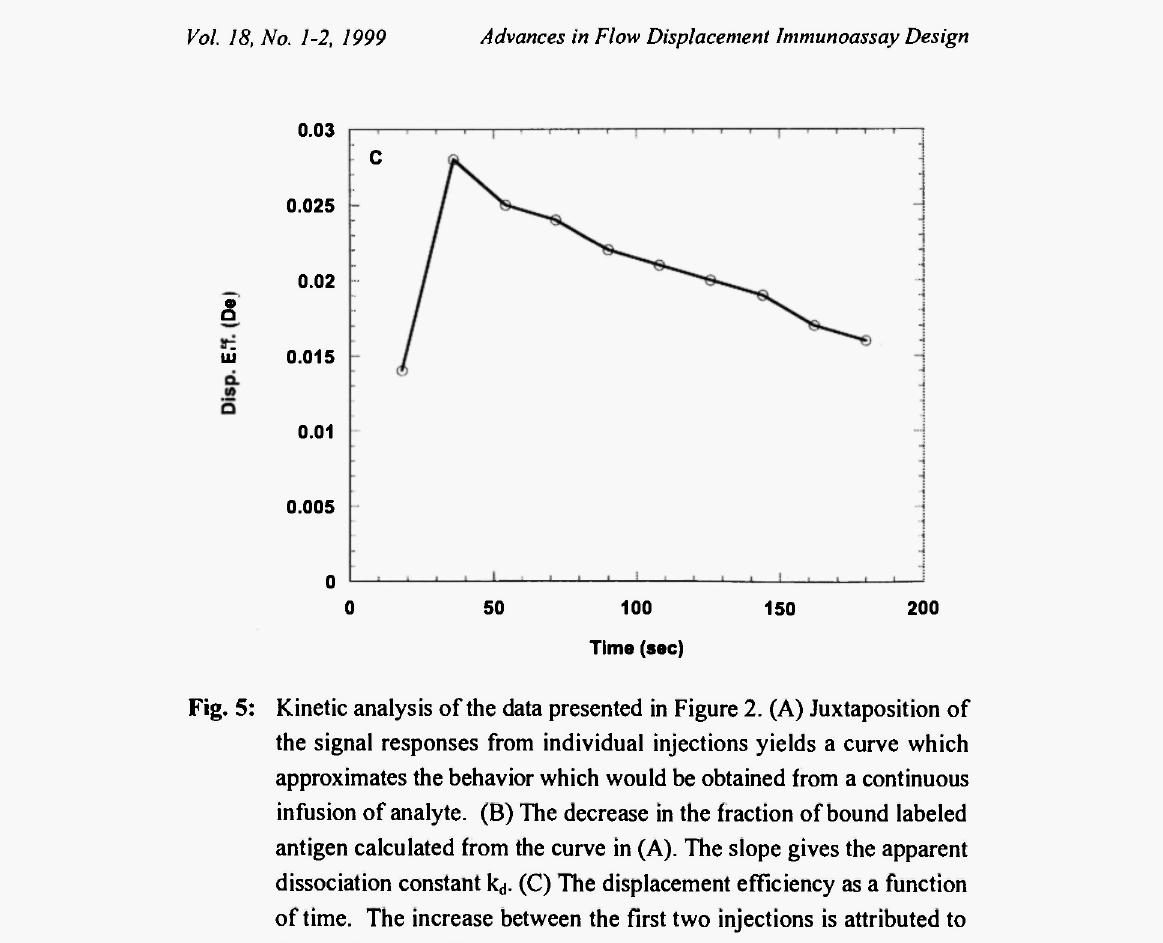
Fig. 5: Kinetic analysis of the data presented in Figure 2. (A) Juxtaposition of the signal responses from individual injections yields a curve which approximates the behavior which would be obtained from a continuous infusion of analyte. (B) The decrease in the fraction of bound labeled antigen calculated from the curve in (A). The slope gives the apparent dissociation constant k d . (C) The displacement efficiency as a function of time. The increase between the first two injections is attributed to free antibody binding